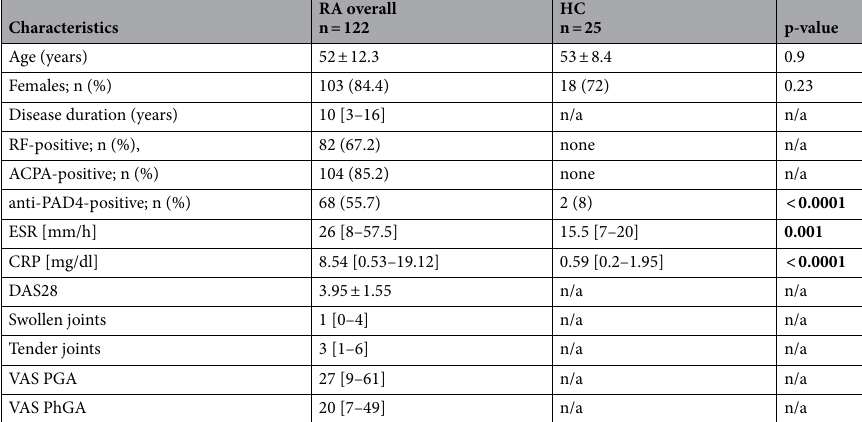
Table 1. Characteristics of the subjects. Data are presented as mean ± SD; median [interquartile range] or number (%). Abbreviations: ACPA, anti-citrullinated protein antibodies; CRP, C-reactive protein; PAD4, peptidyl arginine deiminase type 4; ESR, erythrocyte sedimentation rate; HC, healthy controls; RA, patients with rheumatoid arthritis; RF, rheumatoid factor; VAS PhGA, visual analog scale physician global assessment; VAS PGA, visual analog scale patient global assessment. Significant values are in